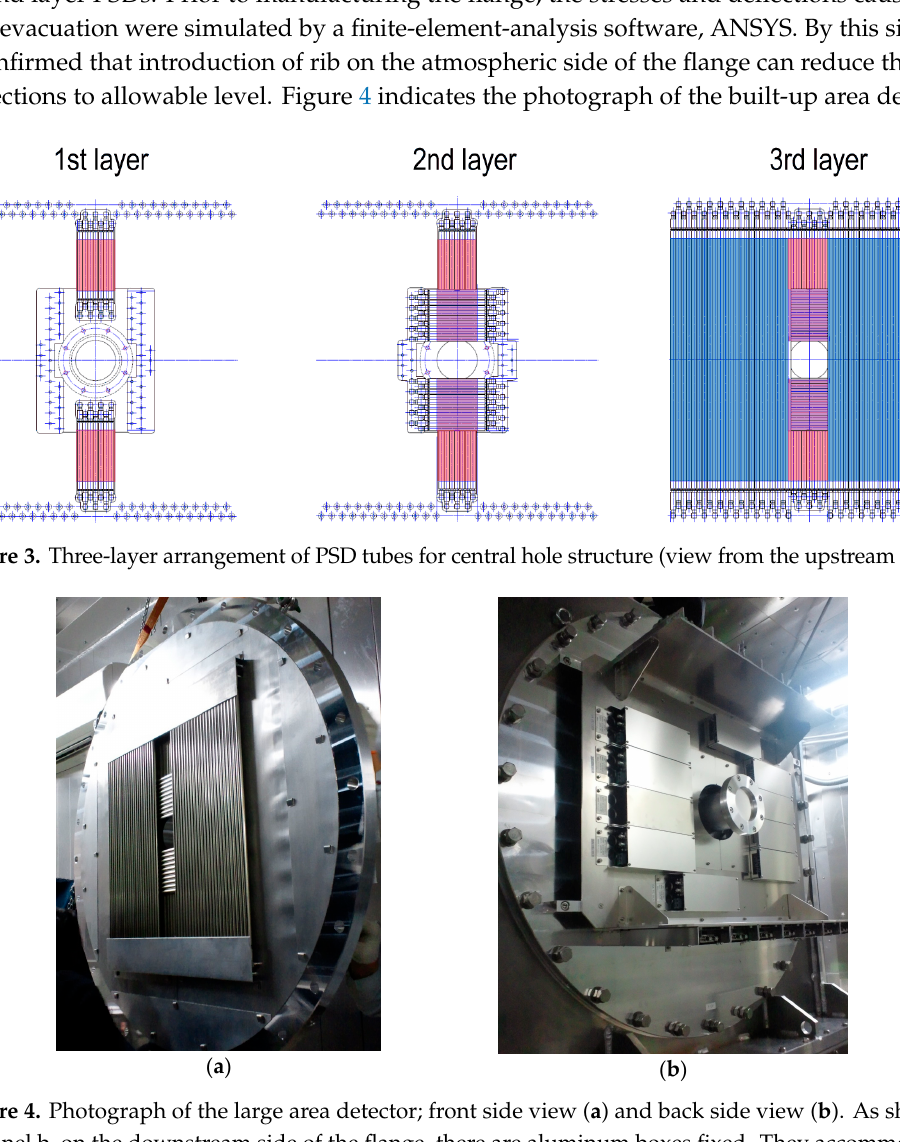
Figure 4. Photograph of the large area detector; front side view ( a ) and back side view ( b ). As shown in panel b, on the downstream side of the flange, there are aluminum boxes fixed. They accommodate electronic boards of charge amplifiers for the signals from